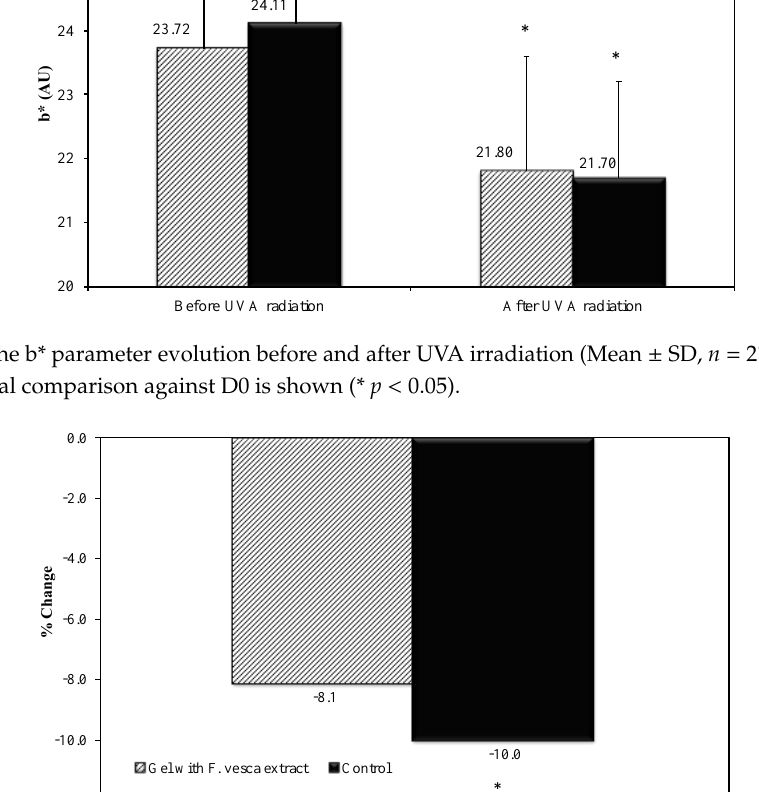
Figure 5. The b* parameter % change before and after UVA irradiation (Mean ± SD, n = 21). Moreover, the statistical comparison against the D0 is shown (* p < 0.05).